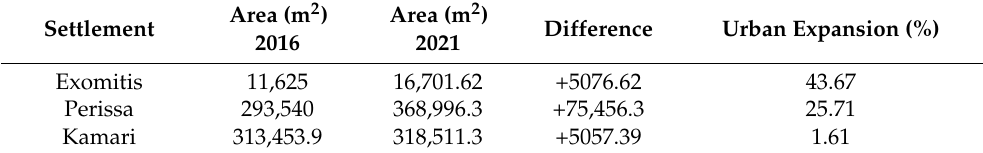
Table 6. Santorini’s coastal settlements evolution for the time period